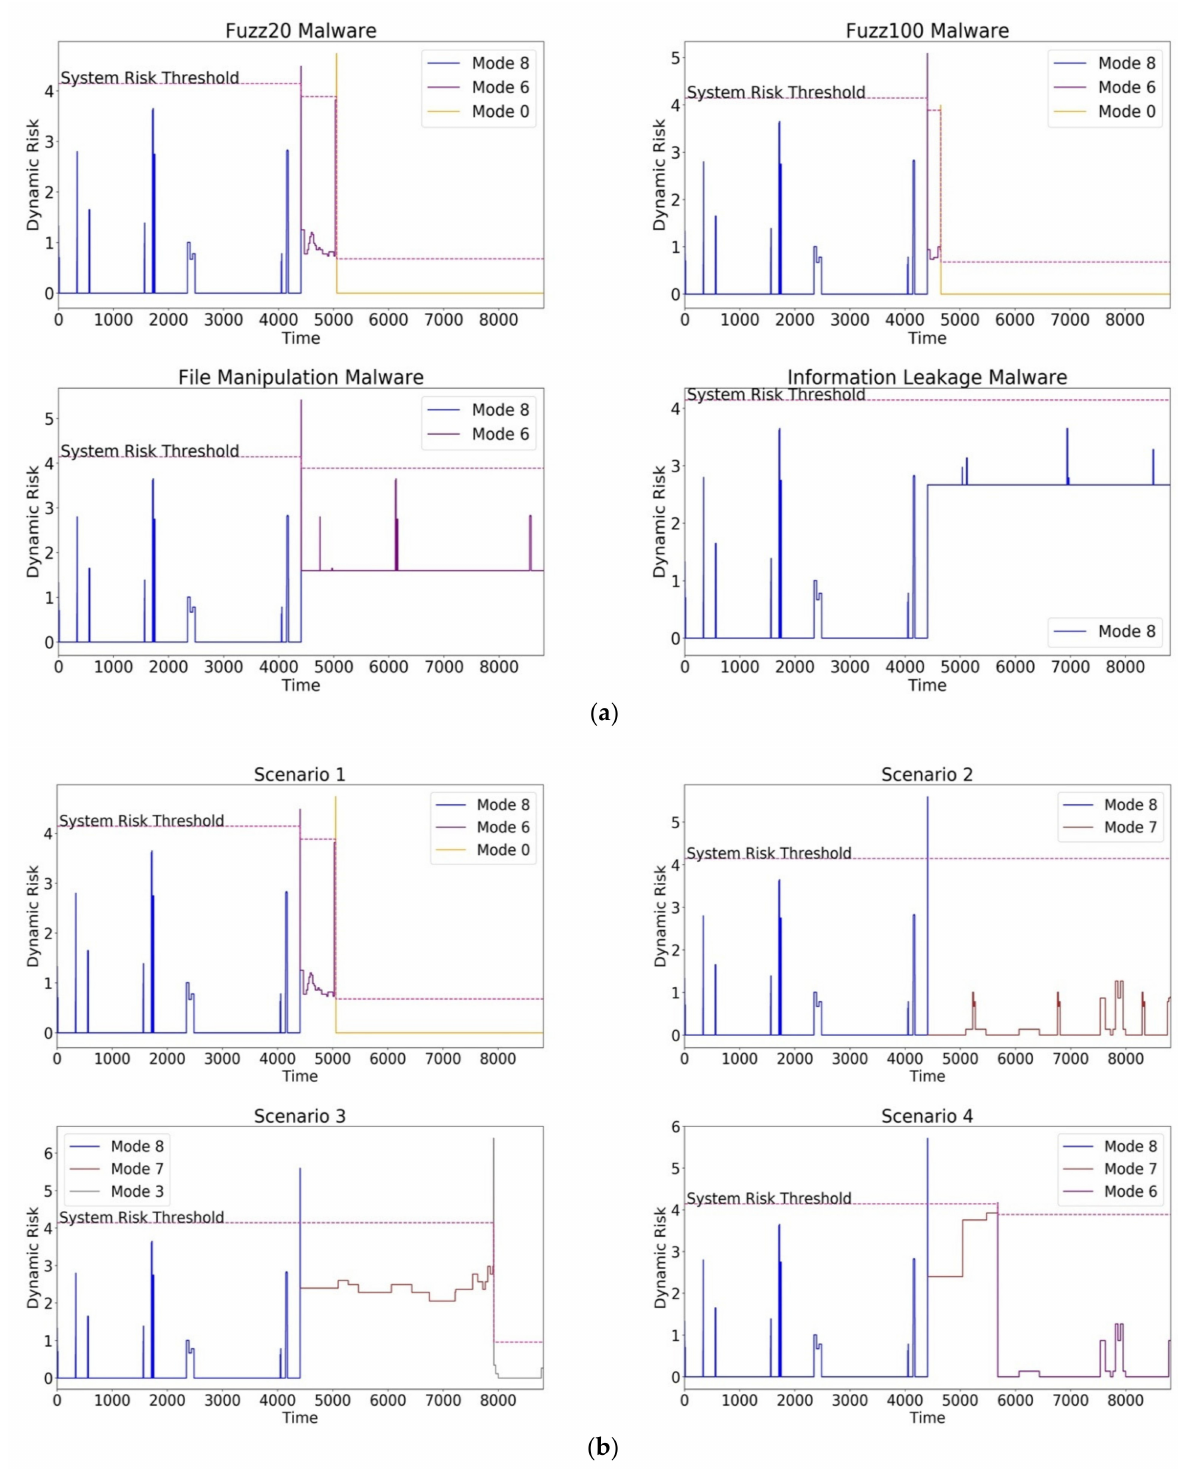
Figure 12. Simulation results plotting the insulin pump system dynamic risk vs. execution time for: ( a ) real security threat malware samples, including Fuzz20, Fuzz100, file manipulation, and information leakage, and ( b ) scenarios demonstrating automatic mode switching for synthesized security